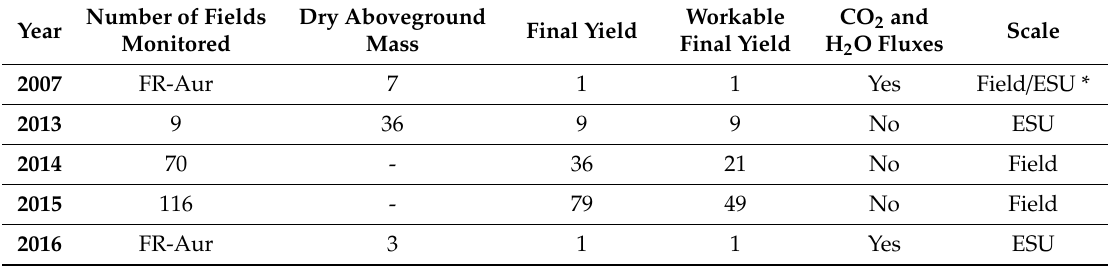
Table 2. Dataset of dry aboveground mass (DAM) and yield as well as their measurement scale. Number of Fields Dry Aboveground Final Yield Year Monitored Mass